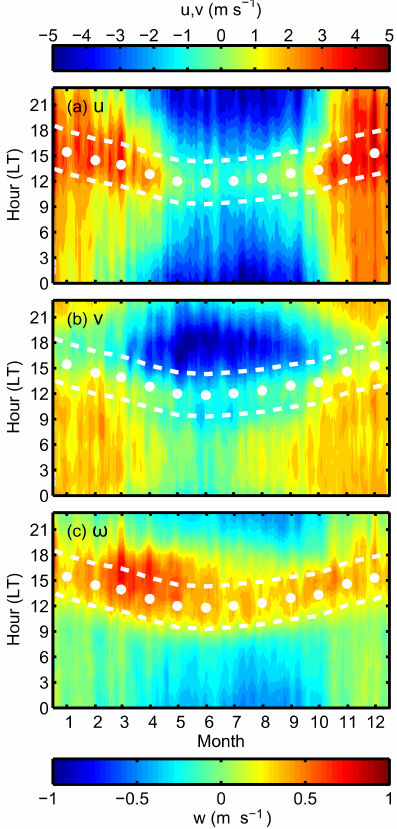
Figure 2. The average season–diurnal variation of surface zonal (a) , meridional (b) and vertical (c) wind velocity on top of Mt Waliguan during 1995–2013. The monthly average hour associated with the diurnal maximum zonal wind speed is given by the white dots, the daytime range is provided by the white dashed lines, which covers 6h centred around the white